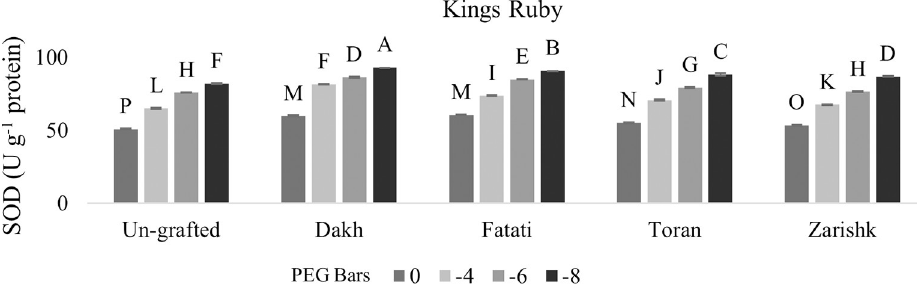
Fig 9. Superoxidase dismutase (SOD) enzymatic activity of un-grafted and grafted Kings Ruby scion variety grafted on different wild grapevines under drought stress condition. Data is represented as mean SD and letters showed significant difference at p < 0.05.